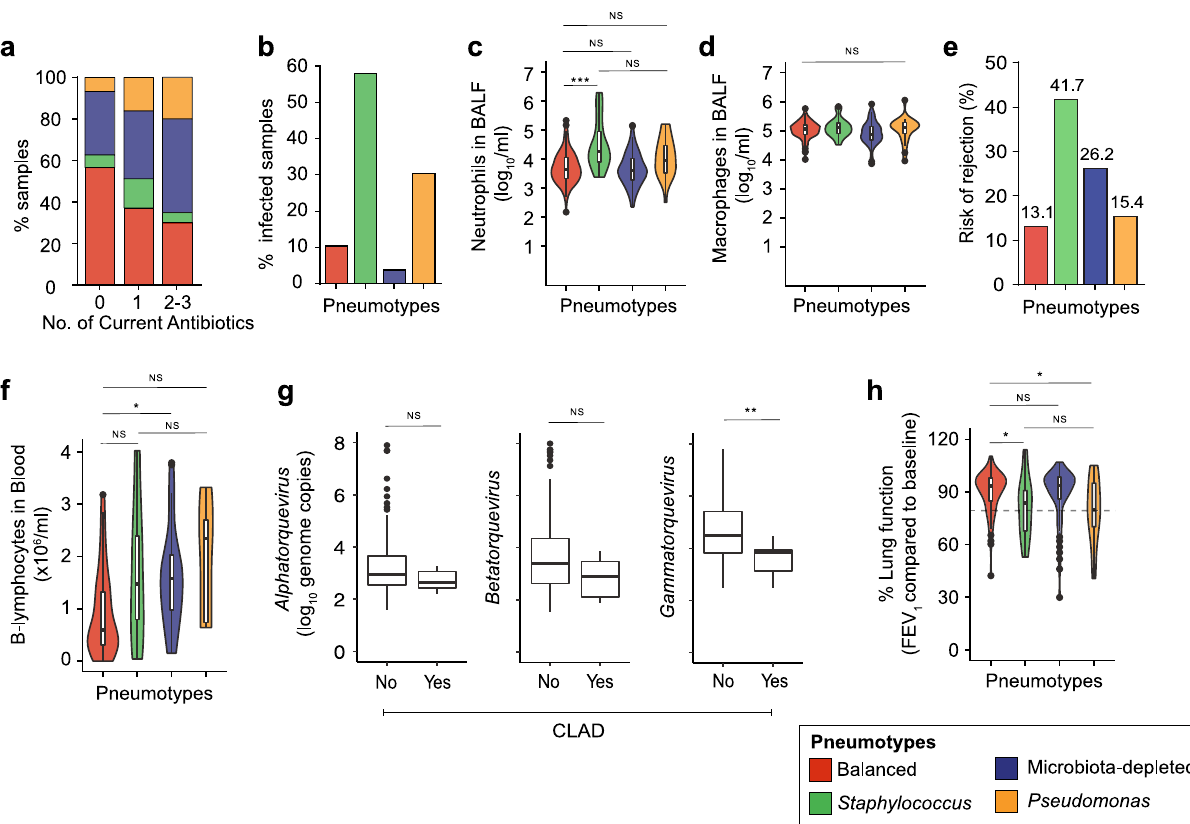
Fig. 6 Association of post-transplant pneumotypes with pulmonary environment, local and peripheral host immunity and clinical status. a Stacked bar plots showing proportion of samples associated ( n = 223, Fisher ’ s test, P = 2.0 × 10 − 3 ) with the four pneumotypes relative to the number of antibiotics administered. b Bar plots show the proportion of infected samples across four pneumotypes. Presence of infection was categorized as yes/no and statistical analysis was done by a generalized linear model, family = binomial, n = 234, Pneumotype Staphylococcus ; P < 0.001 and Pneumotype Pseudomonas P